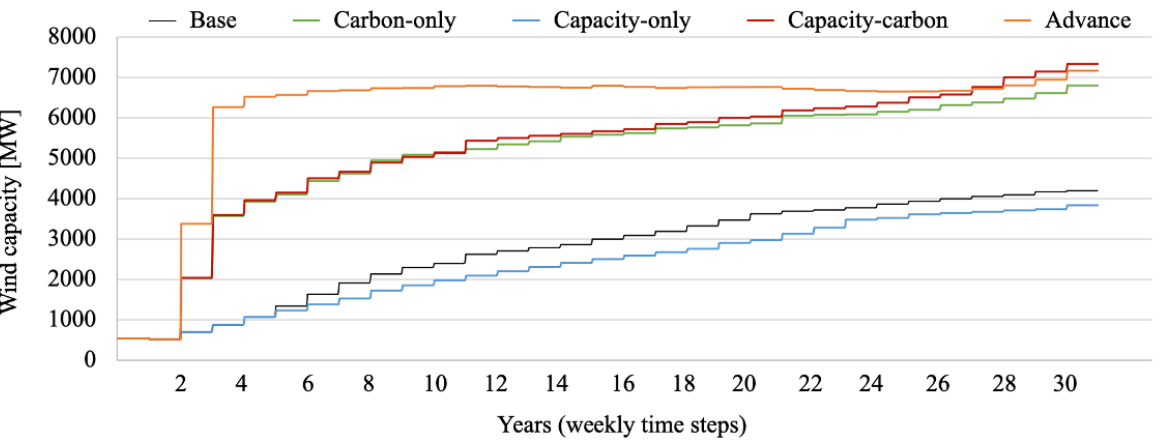
Figure 12. The trajectory of wind power plants ’ capacity change.